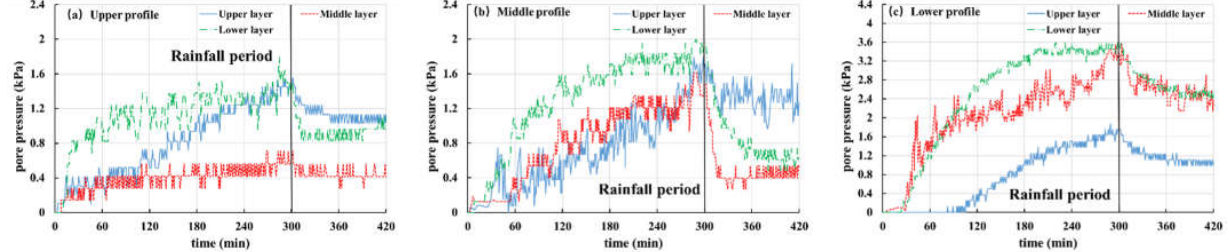
Figure 13. Curves of pore pressure in Test 3 (10 mm, 30 mm/h): ( a ) upper profile; ( b ) middle profile; ( c ) lower profile.